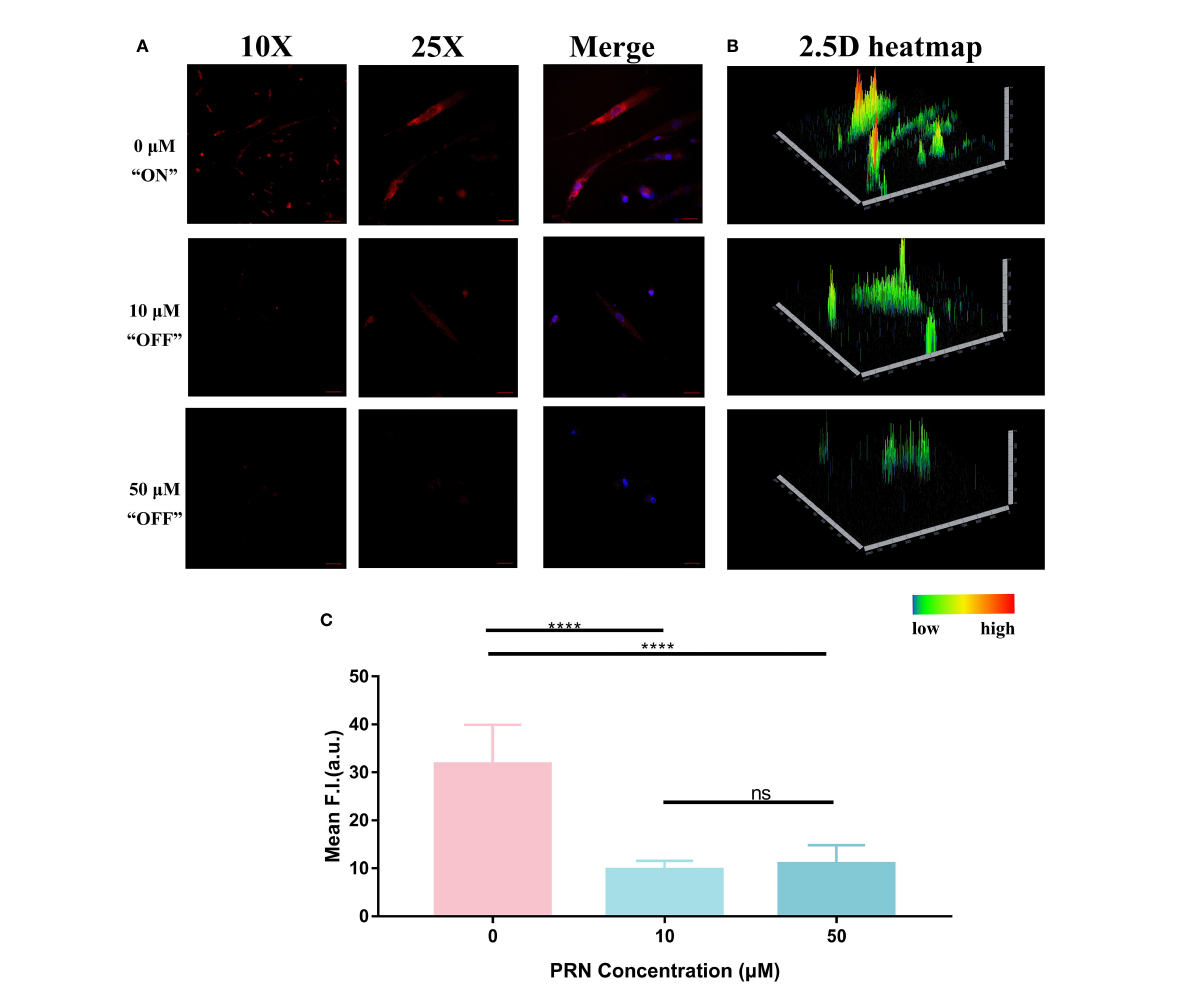
FIGURE 7 (A) Fluorescence imaging of HemECs pretreated with different concentrations of PRN (50 m M, 10 m M, and 0 m M group). HemECs were treated with PRN in different concentrations (50 m M, 10 m M, and 0 m M) for 1 hour. After washed by PBS for 3 times, 40 m M HNT-NTR was added to evaluate the fl uorescence signal. DAPI was used to locate the cells. When compared to 0 m M, the other 2 groups exhibited weaker fl uorescence signal, indicating that PRN could modify the hypoxic status of HemECs and inhibit the fl uorescence signal of HNT-NTR. (B) The 2.5D reconstruction heatmaps corresponded to each group. The 2.5D heatmap of PRN treated group exhibited lower bars and more green/dark area compared to the control group. (C) Quantitative analysis on the fl uorescence intensity of each group. The 0 m M group exhibited signi fi cantly higher fl uorescence signal compared with the other PRN treated groups (P ≤ 0.0001). Besides, the fl uorescence intensity of 0 m M group was approximately 3 times as high as the other 2 groups, indicating that PRN could modify the hypoxic status of HemECs at low concentrations ( ≤